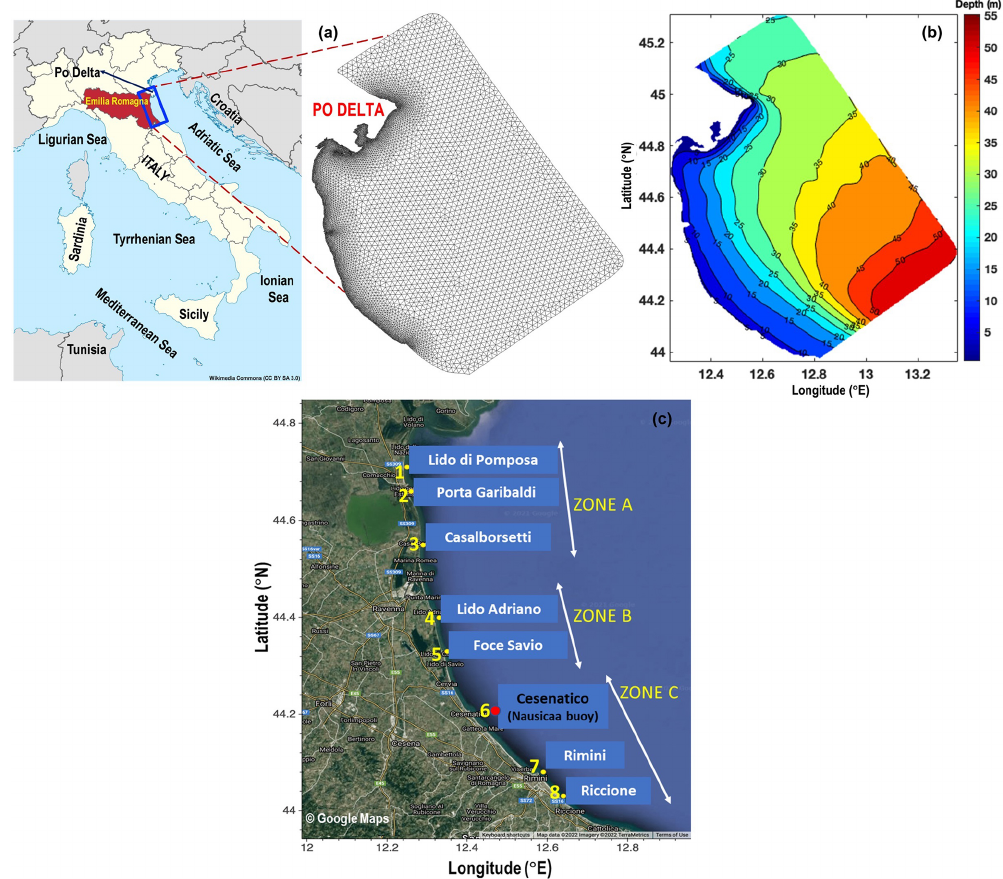
Figure 1. (a) The Emilia-Romagna coastal belt with the unstructured mesh, (b) bathymetry for the model domain, and (c) the control points across the coastal belt used for analysis and validation. The Nausicaa buoy in Cesenatico (at station 6) was used in this study to validate the hindcast wave